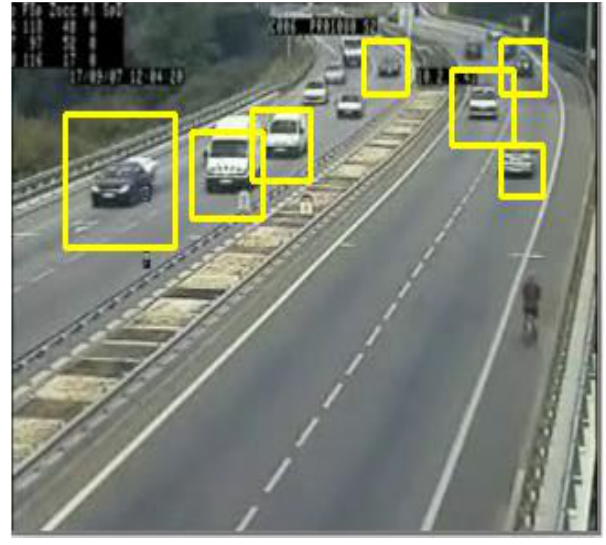
Figure 5. When user selects car detection (ref. Figure 4).